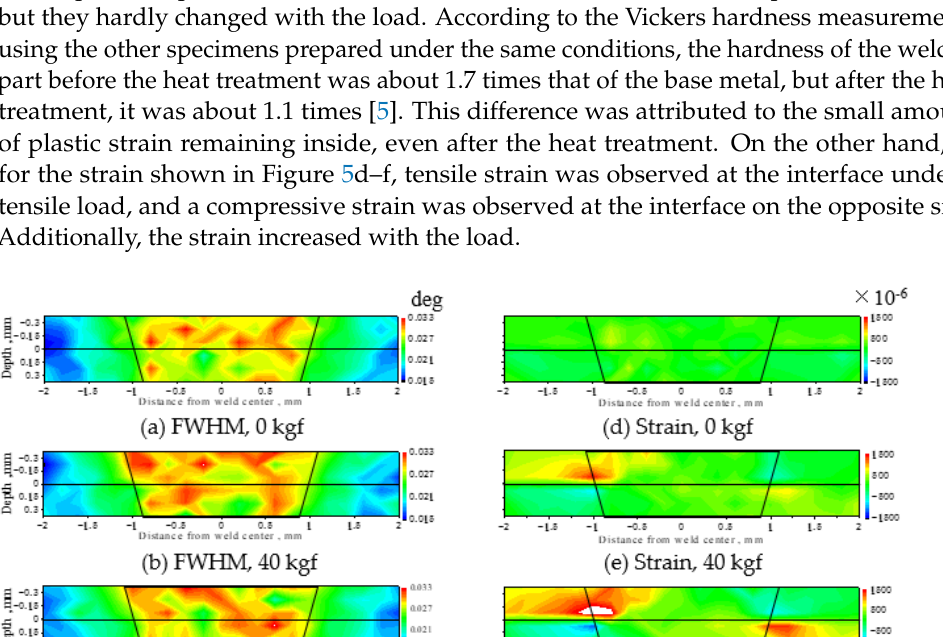
Figure 5. Two-dimensional distribution of the full width at the half maximum (FWHM) of the α− Fe211 diffraction profile and lattice strain at 530 °C under a tensile load.